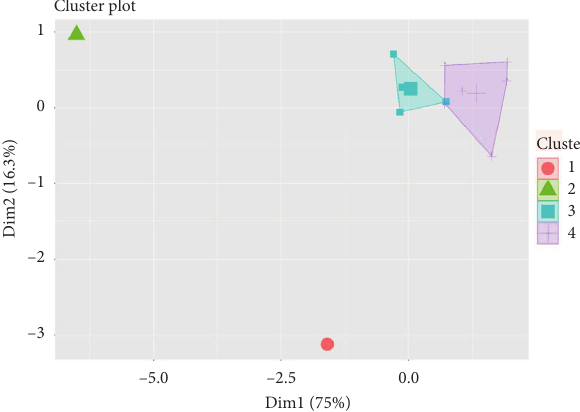
Figure 9: Cluster plot of hierarchical cluster algorithm.